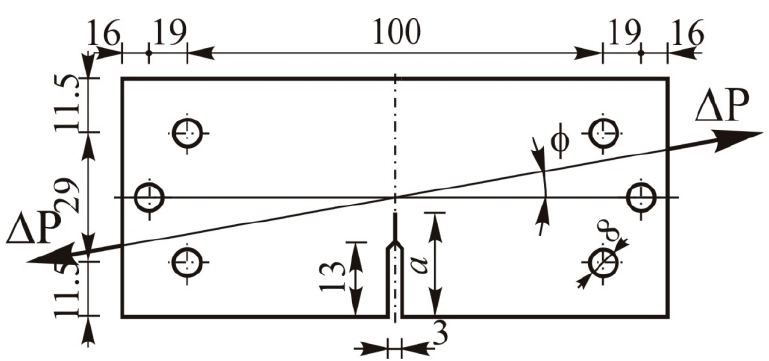
Figure 5. Geometry of the plate with edge crack-like flaw subjected to mixed-mode loading with overload. All dimensions are in millimeters.